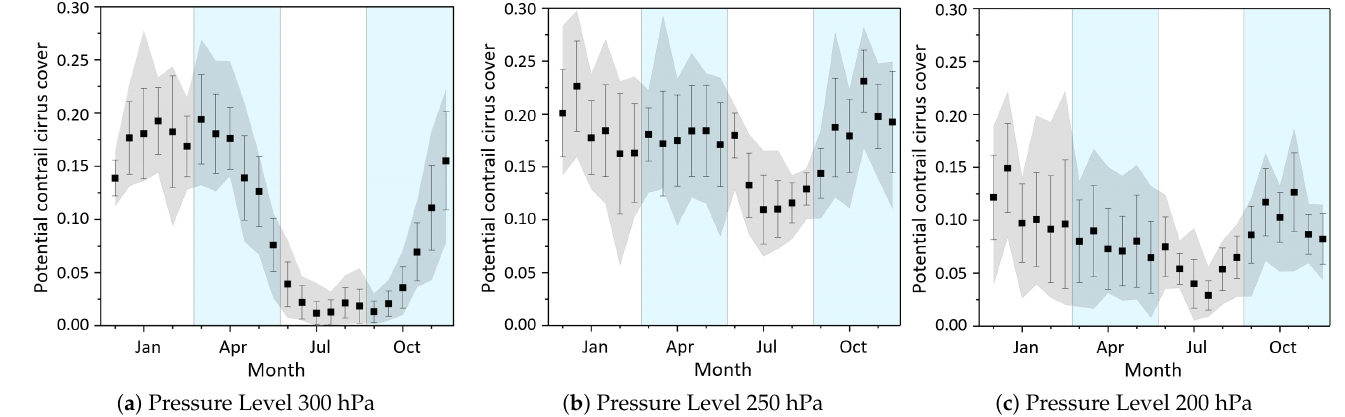
Figure 6. Temporal evolution of the potential contrail cirrus cover ( RH i > 95%) over the year. The potential contrail cirrus cover, including the standard deviation, within the region 35 ◦ N–60 ◦ N, 15 ◦ W–15 ◦ E is calculated for the pressure levels ( a ) 300, ( b ) 250, and ( c ) 200hPa. The vertical sections indicate the seasons, and the grey area marks the minimum and maximum values of the two-week